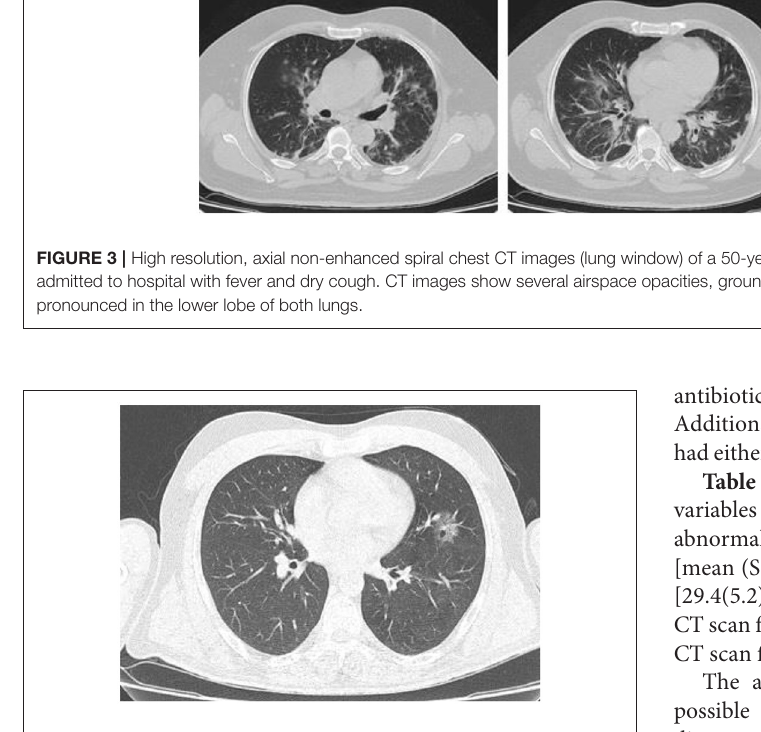
FIGURE 4 | High resolution, axial non-enhanced spiral chest CT image (lung window) of a 44-years old patient who was confirmed to be infected by COVID-19 and admitted to hospital with no symptoms (asymptomatic). CT image shows only a small ground-glass pattern in the lower aspect of the anterior segment of the upper lobe of the left